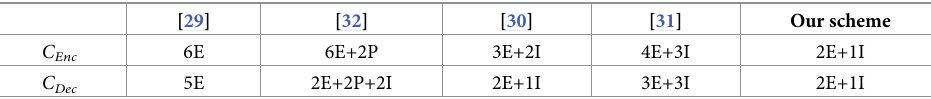
Table 11. The comparison of computational complexity with others.